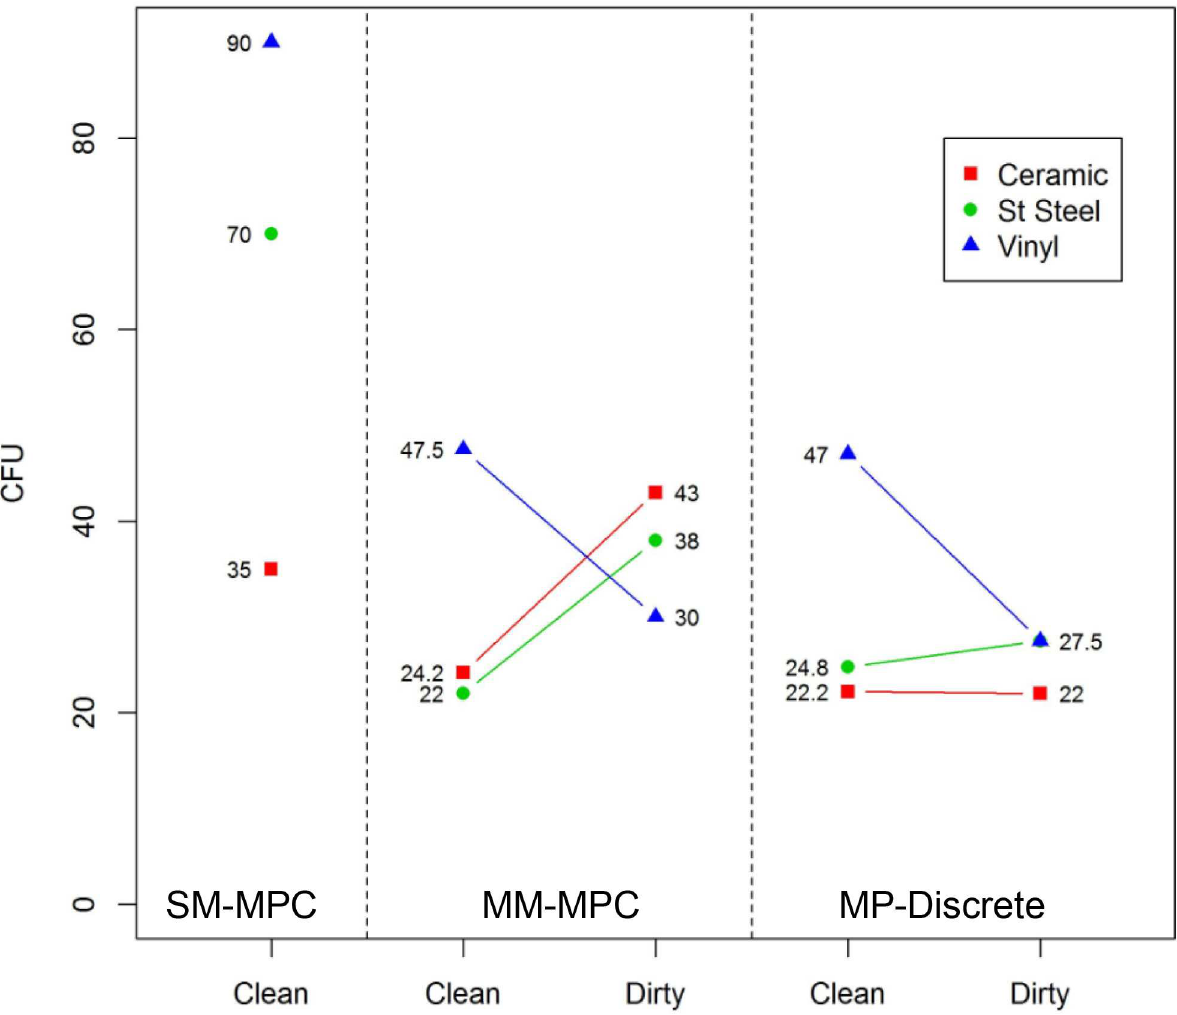
Fig 10. Limit of Detection (LOD90) is lower using the MM-MPC method for each coupon material compared to the SM-MPC method. The CFU targets used were 5, 10, 25, 50, and 100 CFU per coupon. Couponswere contaminatedin four or eight locationsfor the both composite